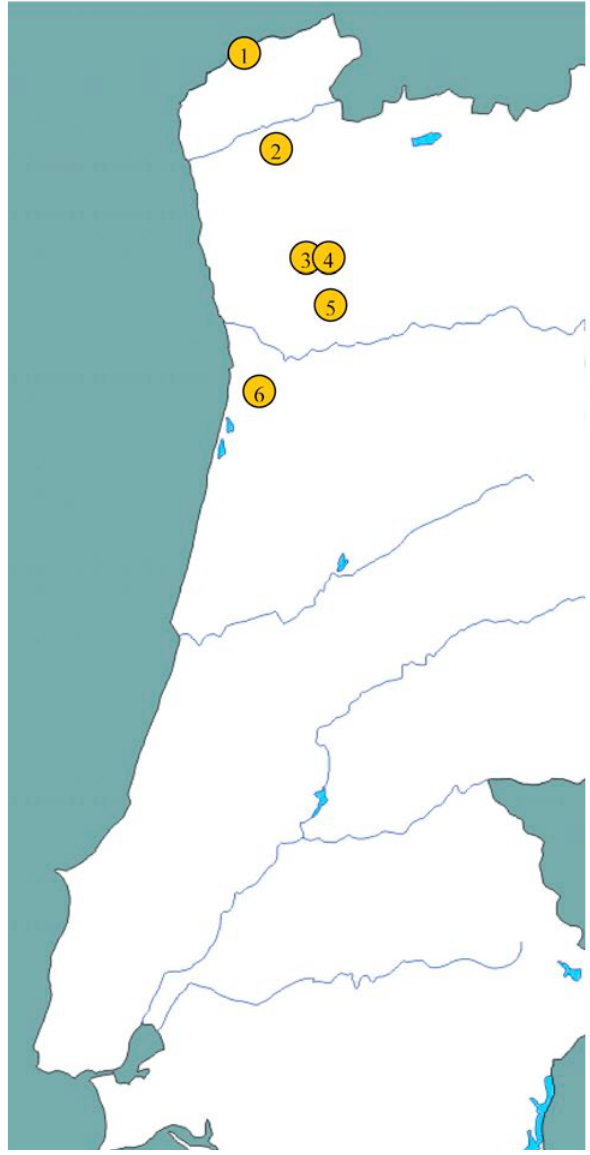
Figure 3. A map of Portugal showing the kiwifruit areas investigated and recordings of Pseudomonas syringae pv. ac- tinidiae in order of time for the main production areas: 1) Valença (2010, 2011); 2) Lago Braga, 3) Quinta dos Bocas, 4) Felgueiras, 5) Vila boa de Quires, and 6) Santa Maria Da Feira